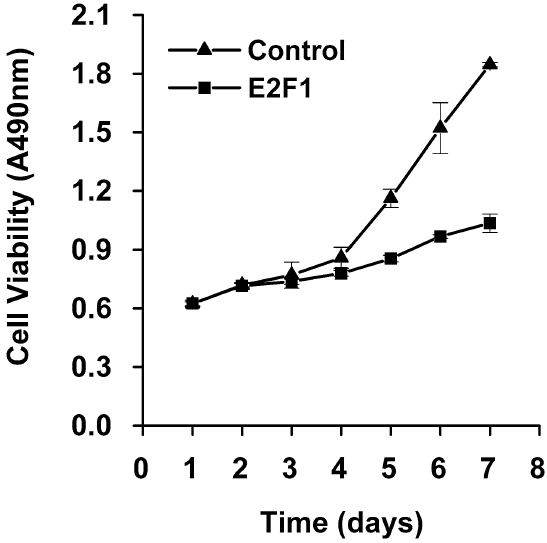
Fig. 3. Verification of the pCMV-E2F-1-HA recombinant vector con- struct. EcoR I digestion of pCMV-E2F-1-HA revealed a 1.3-kb frag- ment, representing the exogenous E2F-1 insert; no fragment resulted from digestion of the empty vector, pCMV-HA. M, DGL2000 DNA marker; Lane 1, cloned vector pCMV-E2F-1-HA; Lane 2, empty vector pCMV-HA.